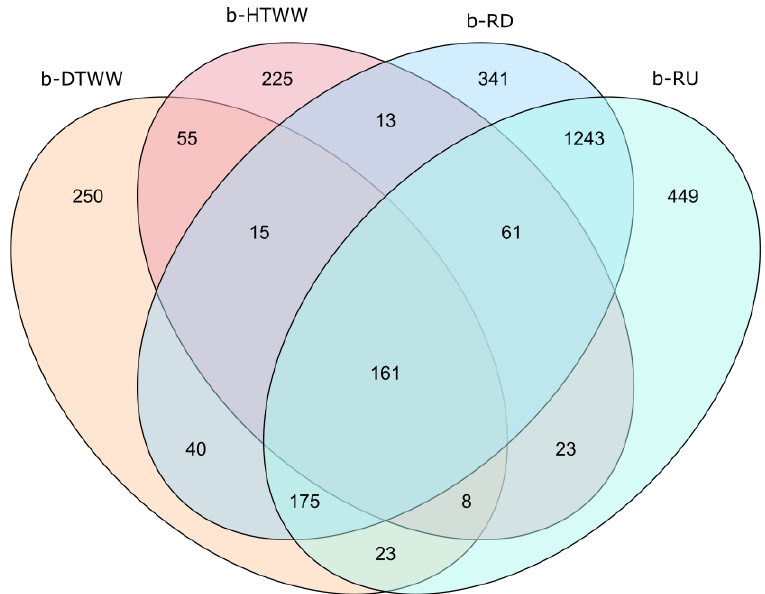
Figure 5. Venn diagram showing the distribution of tpm ASV among rock biofilms developing from domestic treated wastewaters (b-DTWW), hospital treated wastewaters (b-HTWW), and river surface water located downstream (b-RD) or upstream (b-RU) the selected WWTP outlet.